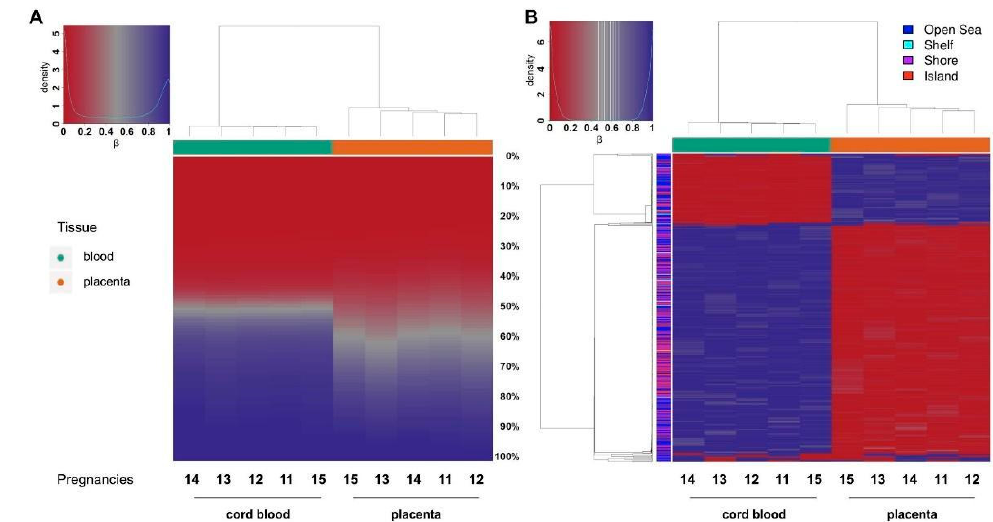
Figure 6. Targeted methylation sequencing: Hierarchical clustering based on CpG methylation score in cord blood (green) and placenta (orange). The heatmaps show ( A ) the relative distribution of CpG site methylation scores ranging from 0 (red) to 100% (blue) in the placenta (green) compared to cord blood (orange); ( B ) the methylation scores for the top 1000 CpG sites based on variance across samples. Color bar on the left indicates CGI relation for each site (shore: <2 kb flanking CpG island; shelf: <2 kb flanking outwards from CpG